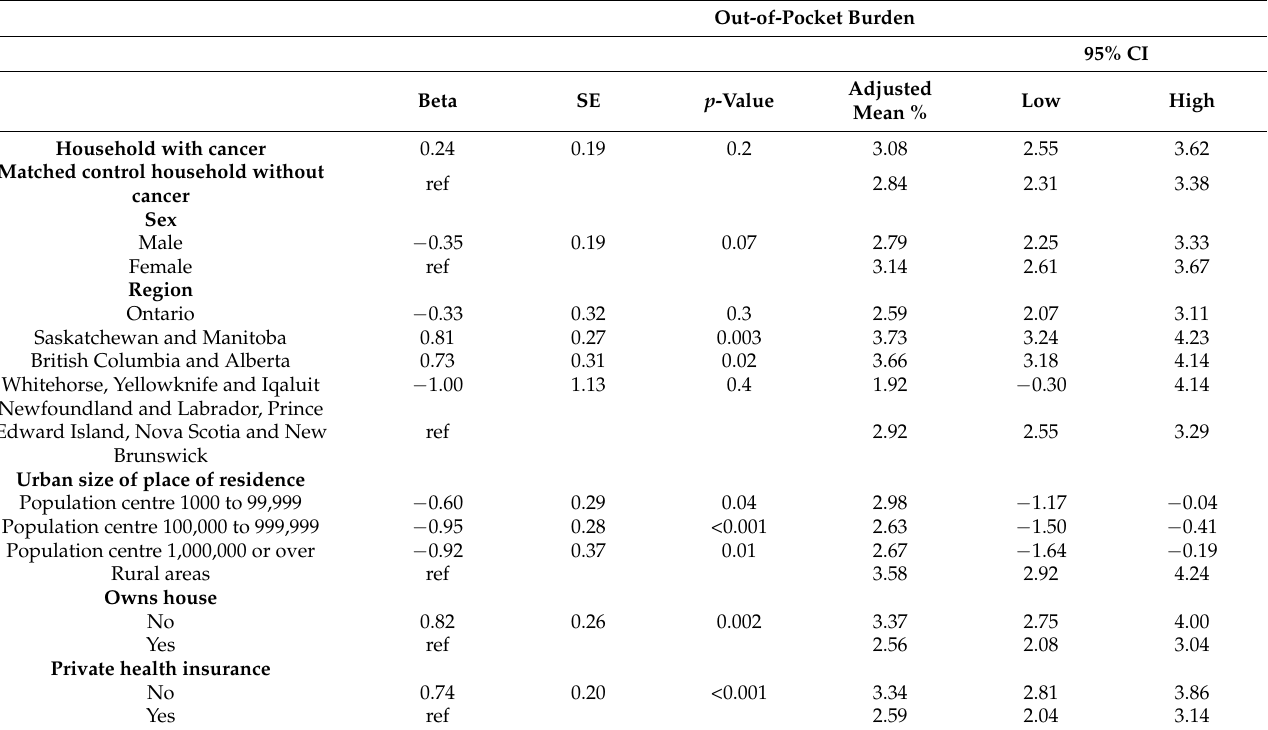
Table 5. Model-adjusted out-of-pocket cost burden for households with cancer and without